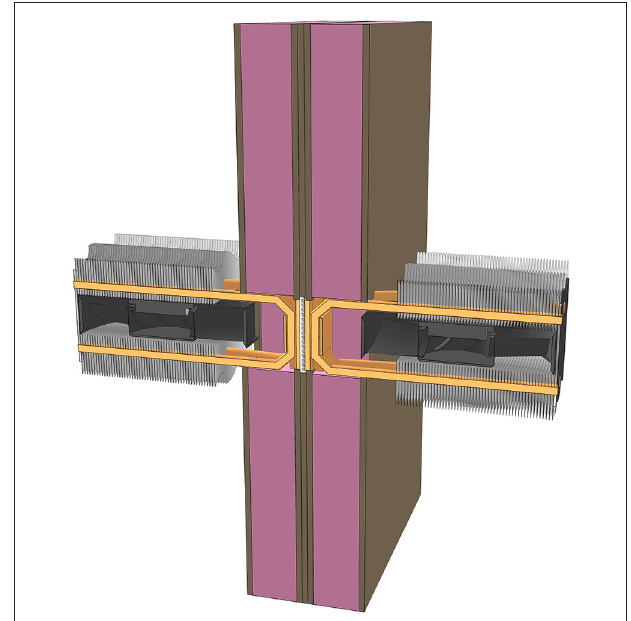
FIGURE 5 | Architectural proof of concept a model section for thermoelectric facade (sink transfer